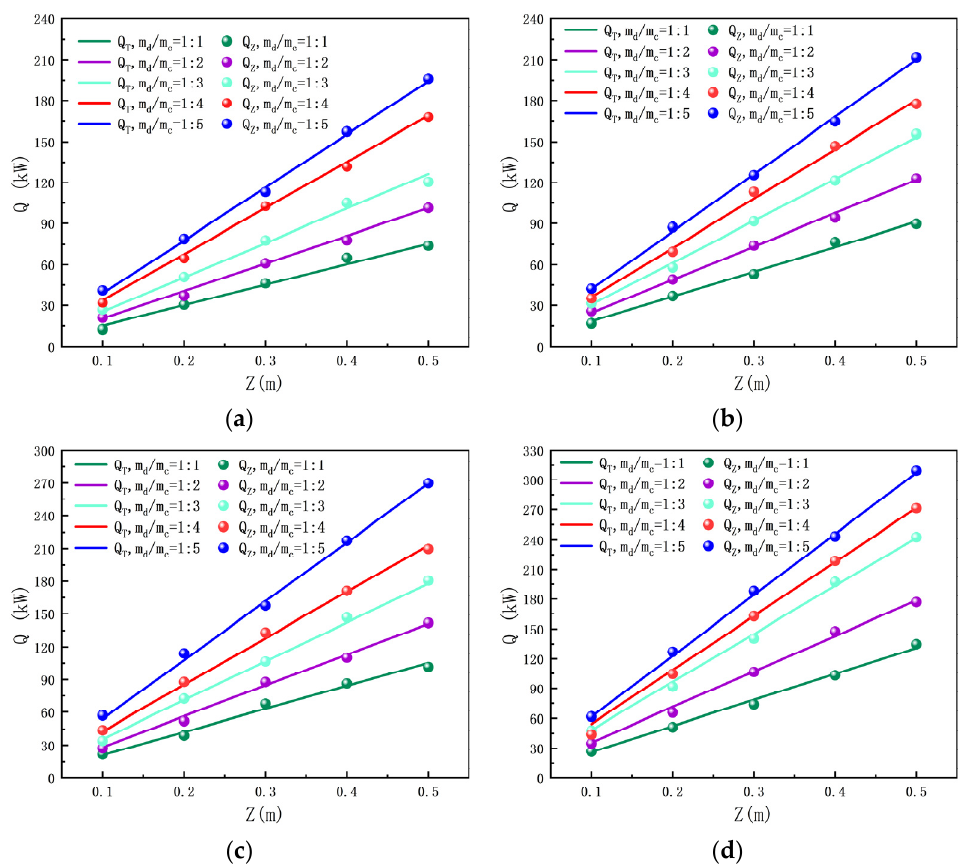
Figure 8. The relationship between heat transfer quantity and height (Z) at different temperatures. ( a ): T c = 50 ◦ C. ( b ): T c = 60 ◦ C. ( c ): T c = 70 ◦ C. ( d ): T c = 80 ◦